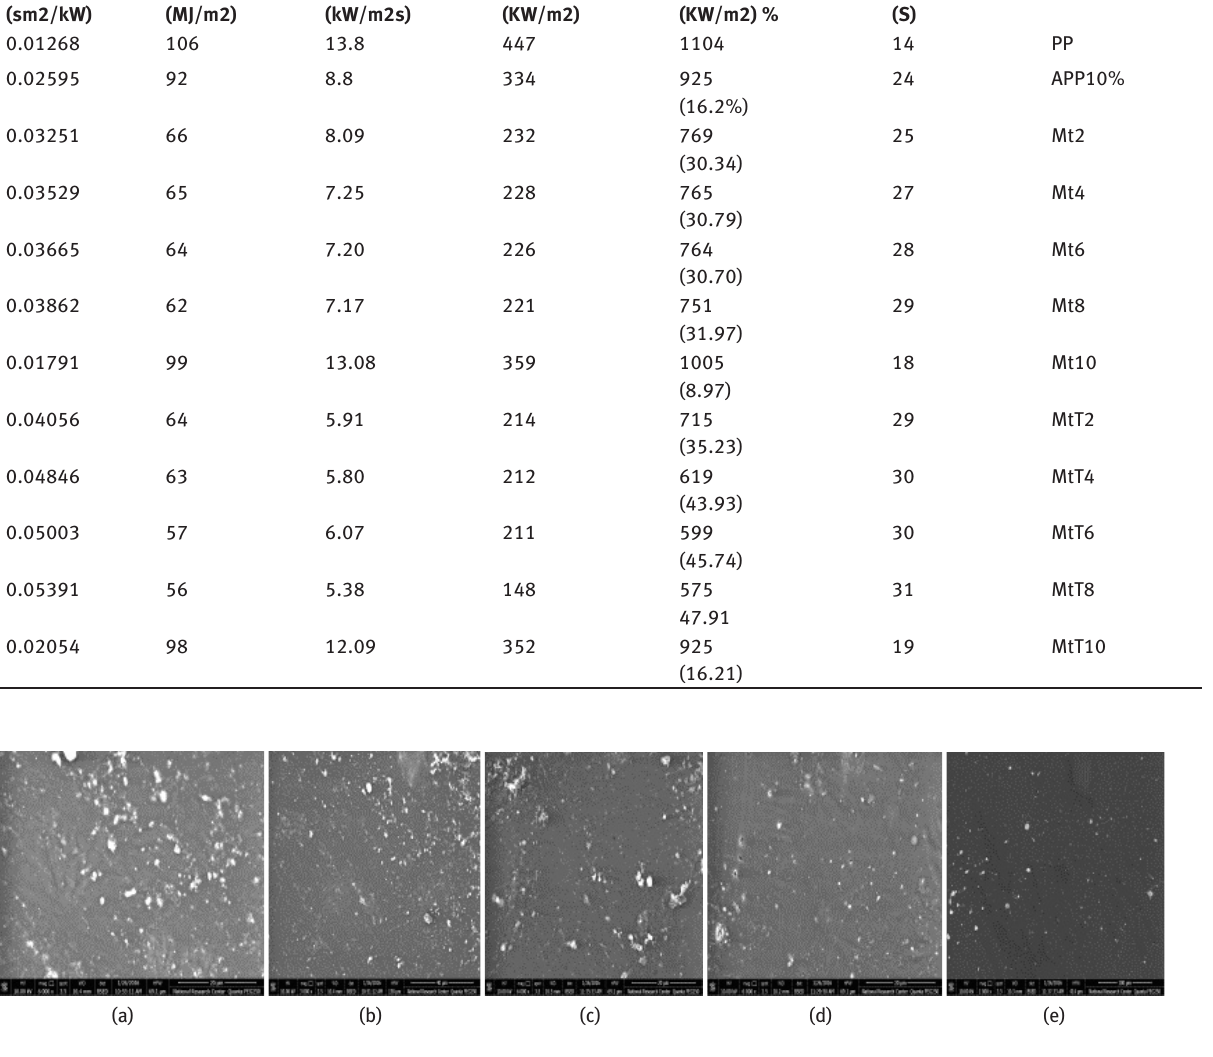
Figure 5: SEM of a)Mt2, b) Mt4, c)Mt6, d)Mt8 and e)Mt10. (The magnification equal 3000).